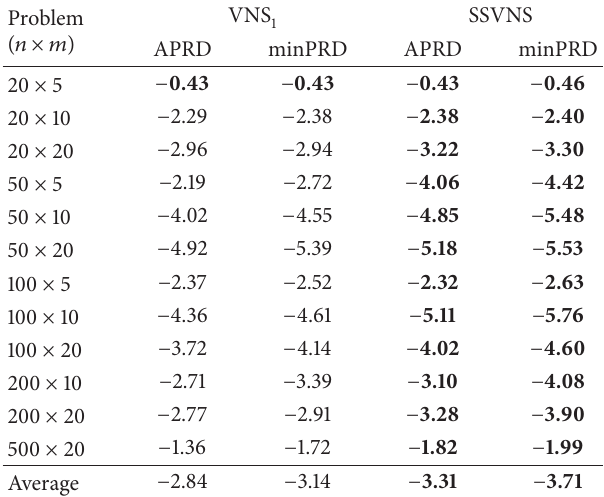
Table 1: Comparison results between VNS and